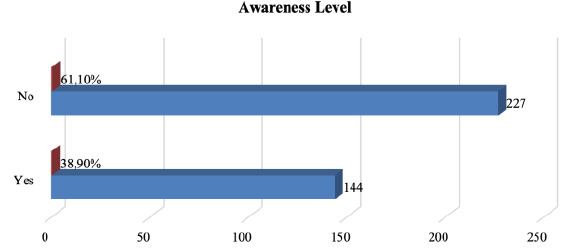
Figure 2: Points Accumulation Awareness; Source: Survey Data (2021)